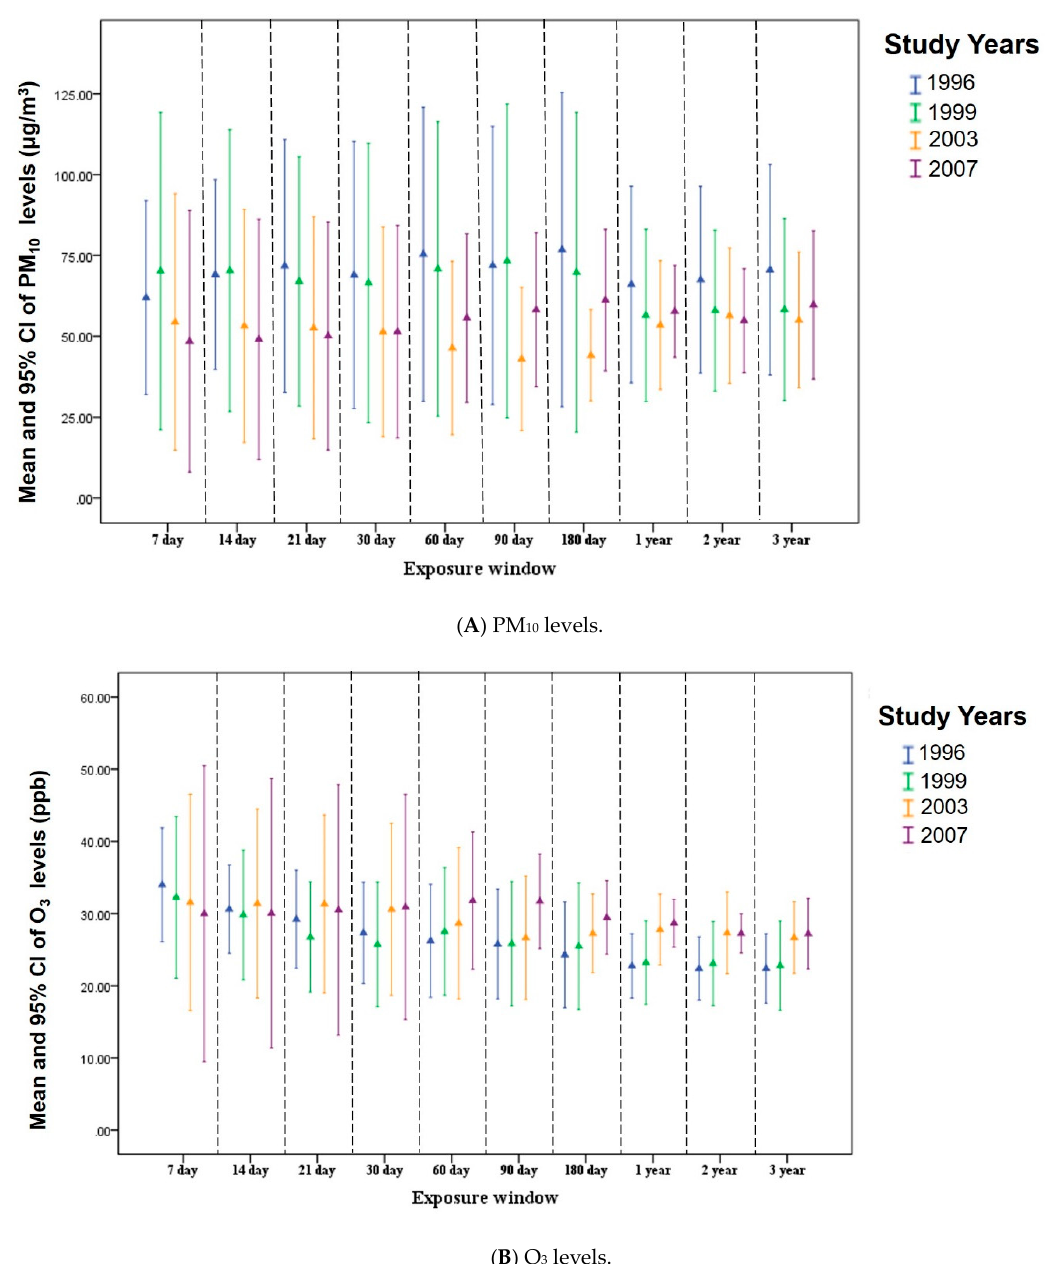
Figure 3. Mean and 95% Confidence Interval of PM 10 ( A ) and O 3 ( B ) concentrations in the 7 days up to 3 years (exposure windows) prior to each participant’s interview day from 1996 to